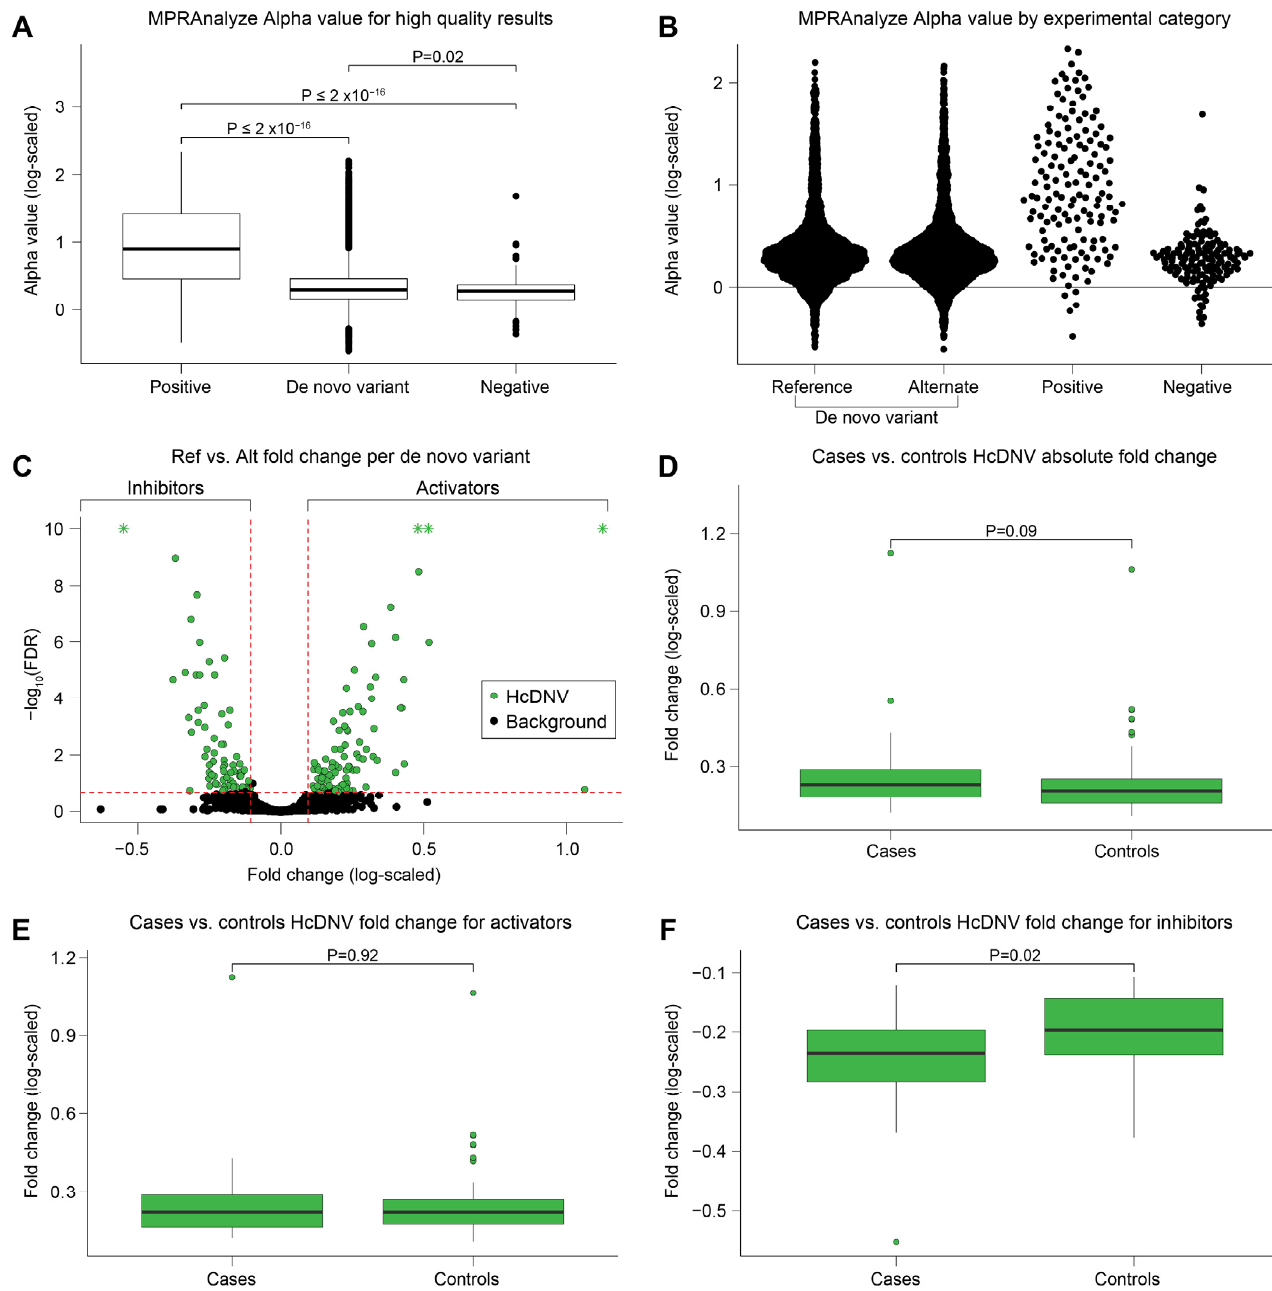
Figure 2. MPRAnalyze results. ( A ) Boxplot comparing the log of the alpha value reported by MPRAnalyze. The p -values above the boxes are Wilcoxon rank sum test p -values comparing the alpha value between the boxes indicated by the end of the brackets. ( B ) Swarm plot of the log alpha values reported in ( A ) showing the density and distribution of the values. ( C ) Volcano plot showing the natural log fold change between the alternate allele alpha value over the reference allele alpha value on the x -axis and the –log10 of the MPRAnalyze FDR reported for the differential expression on the y -axis. Y-axis values greater than 10 have been lowered to 10 and marked with an “*” to zoom in the graph. ( D – F ) Boxplots comparing the log fold change values between HcDNV cases and controls for the absolute value of the log fold change ( D ), activators only ( E ), and inhibitors only ( F ).